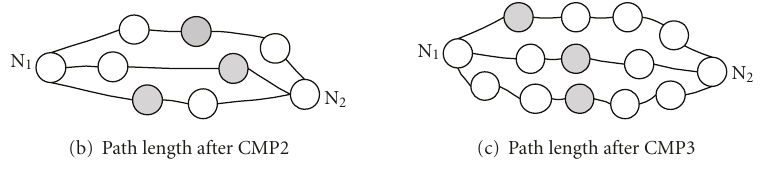
Figure 4: Path length after CMP1, CMP2, and CMP3.